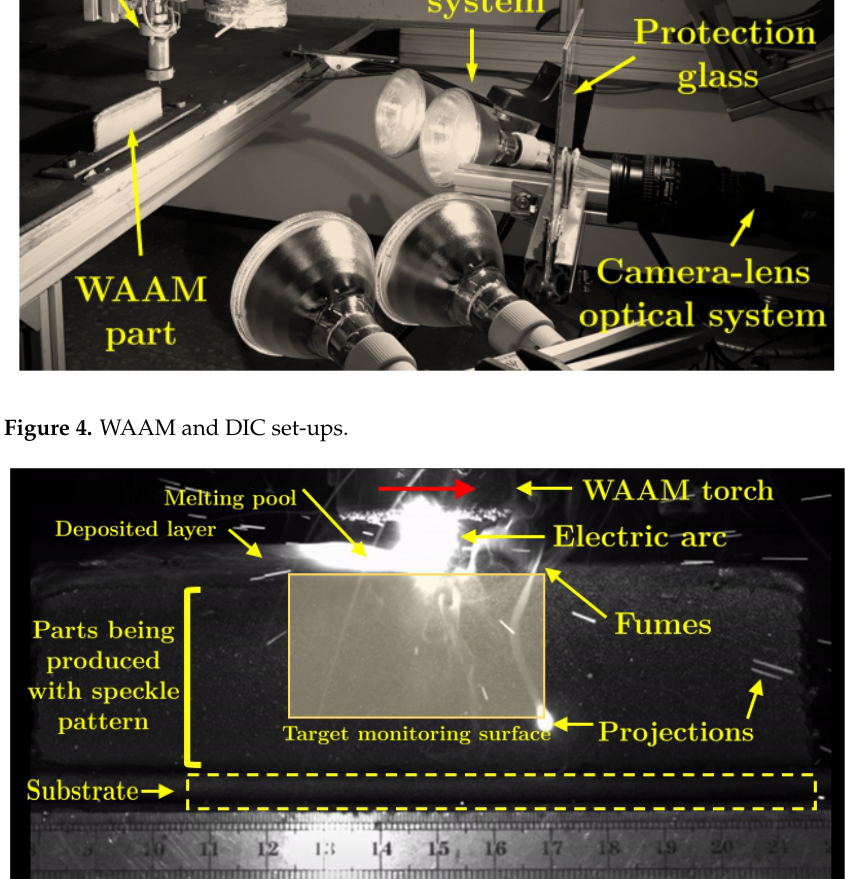
Figure 5. Acquired original image of the WAAM process for DIC purposes.